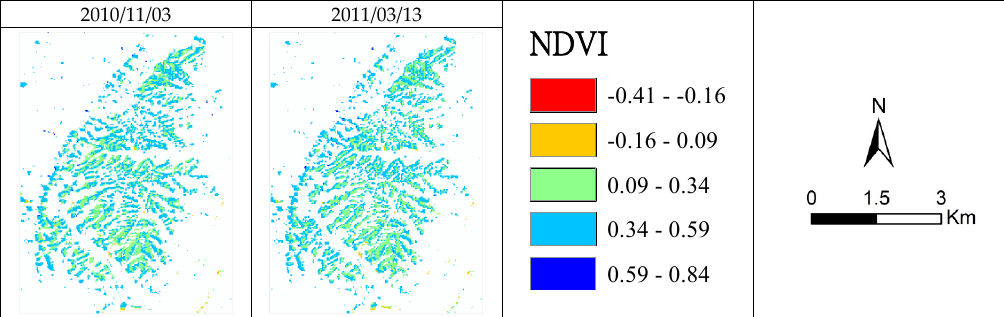
Figure 6. NDVI of landslide area of Mt. Jou-Jou. (Image latitude and longitude coordinates: Upper Left: 24.04 ° , 120.76 ° ; Bottom Right: 23.98 ° , 120.81 ° ).